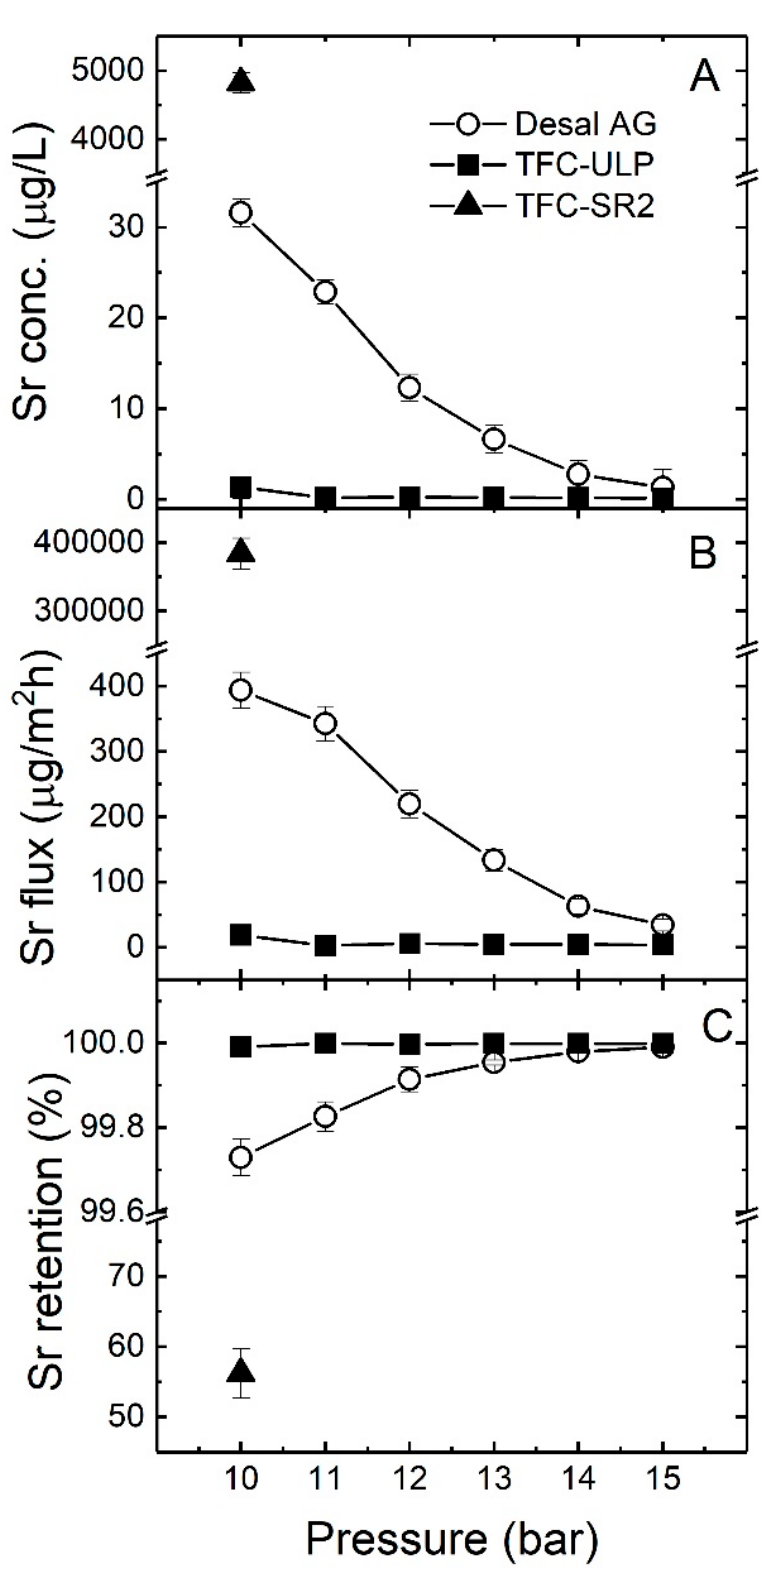
Figure 5. ( A ) Sr permeate concentration, ( B ) Sr flux and ( C ) strontium retention as a function of applied pressure (10–15 bar) with groundwater sample 5 (feed Sr concentration 10.3 mg/L). The pH was about 9, data adapted from [69].